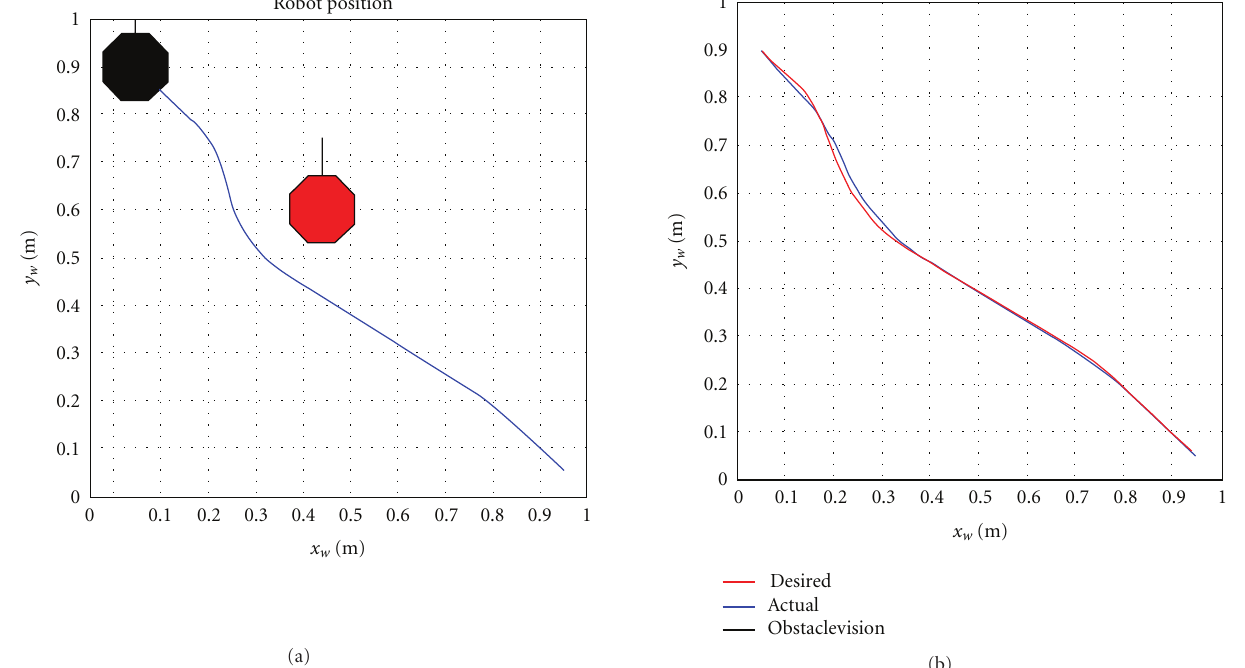
Figure 16: (a) Simulated static obstacle avoidance. (b) Experimental static obstacle avoidance.